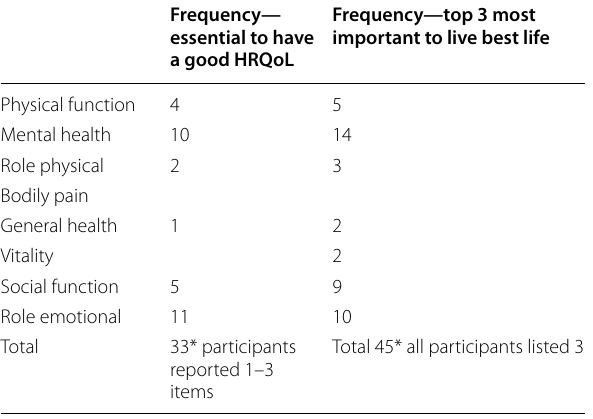
Table 2 Top dimensions of health reported as essential for improving